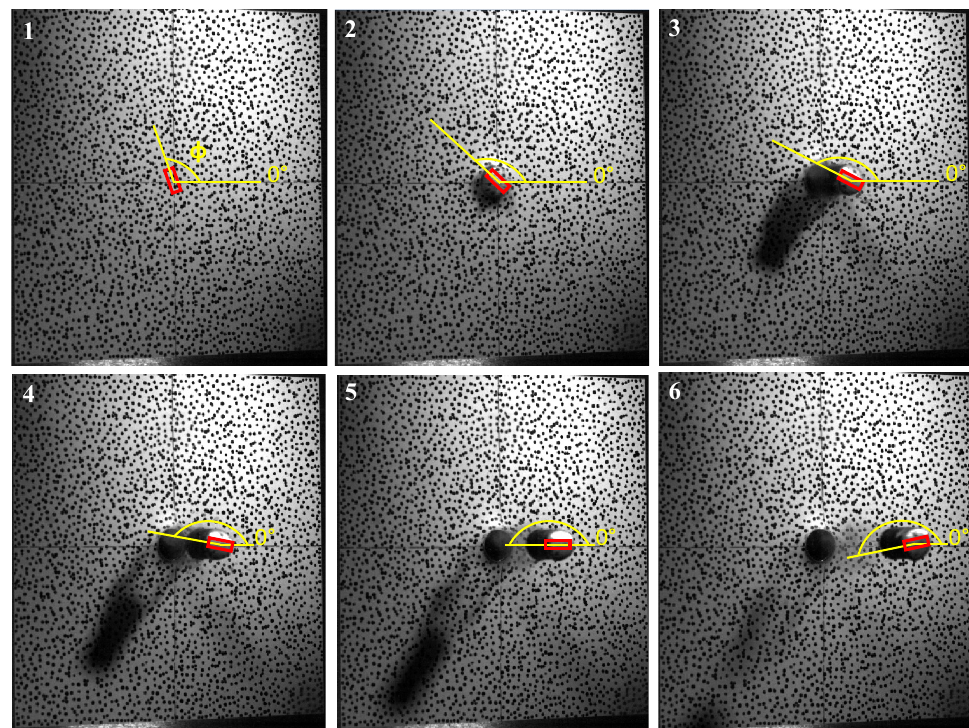
Figure 6. High-speed imaging of ballistic impact (configuration 2) on plate target: tracking FSP front surface angle (image 1) and orientation (images 2 to 6) (Video S3).